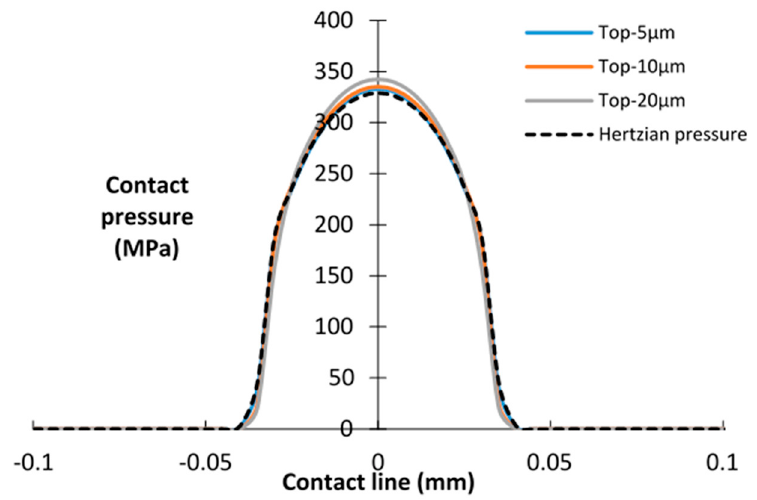
Figure 6. Contact pressure distributions of the top interface for different thicknesses of the debris layer; E = 360 GPa.